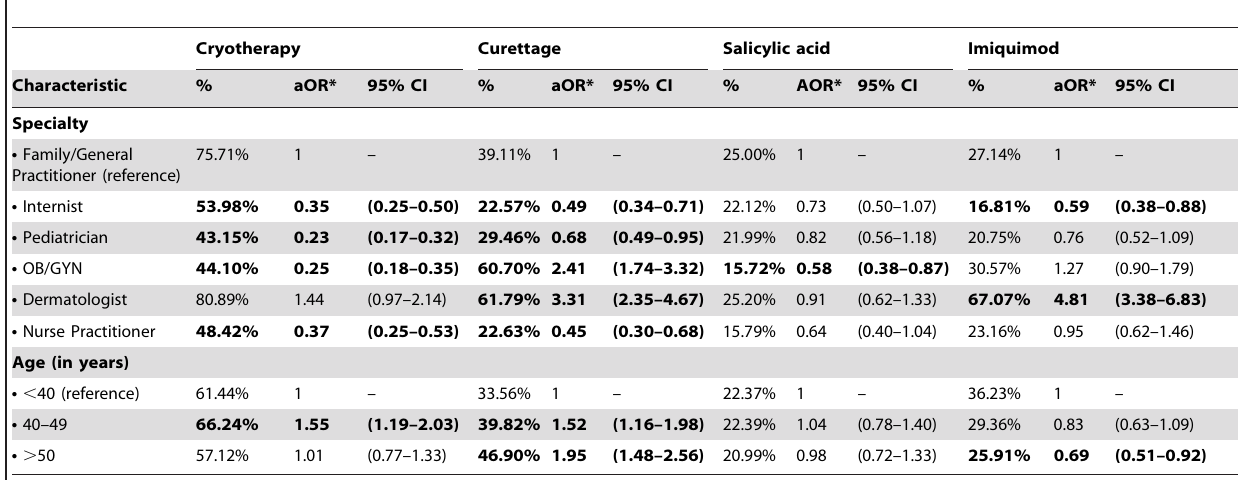
Table 4. Frequencies and adjusted odds ratios of various characteristics with treatment option responses for